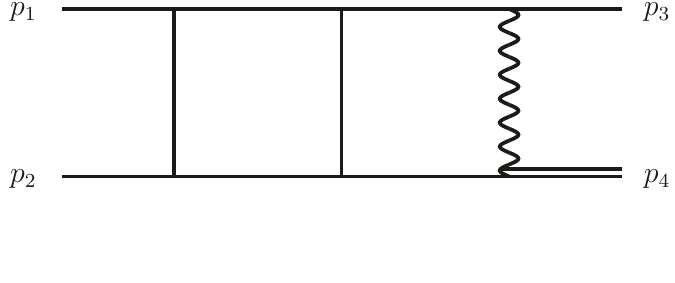
Figure 1 . Two loop graph of the planar topology 1.